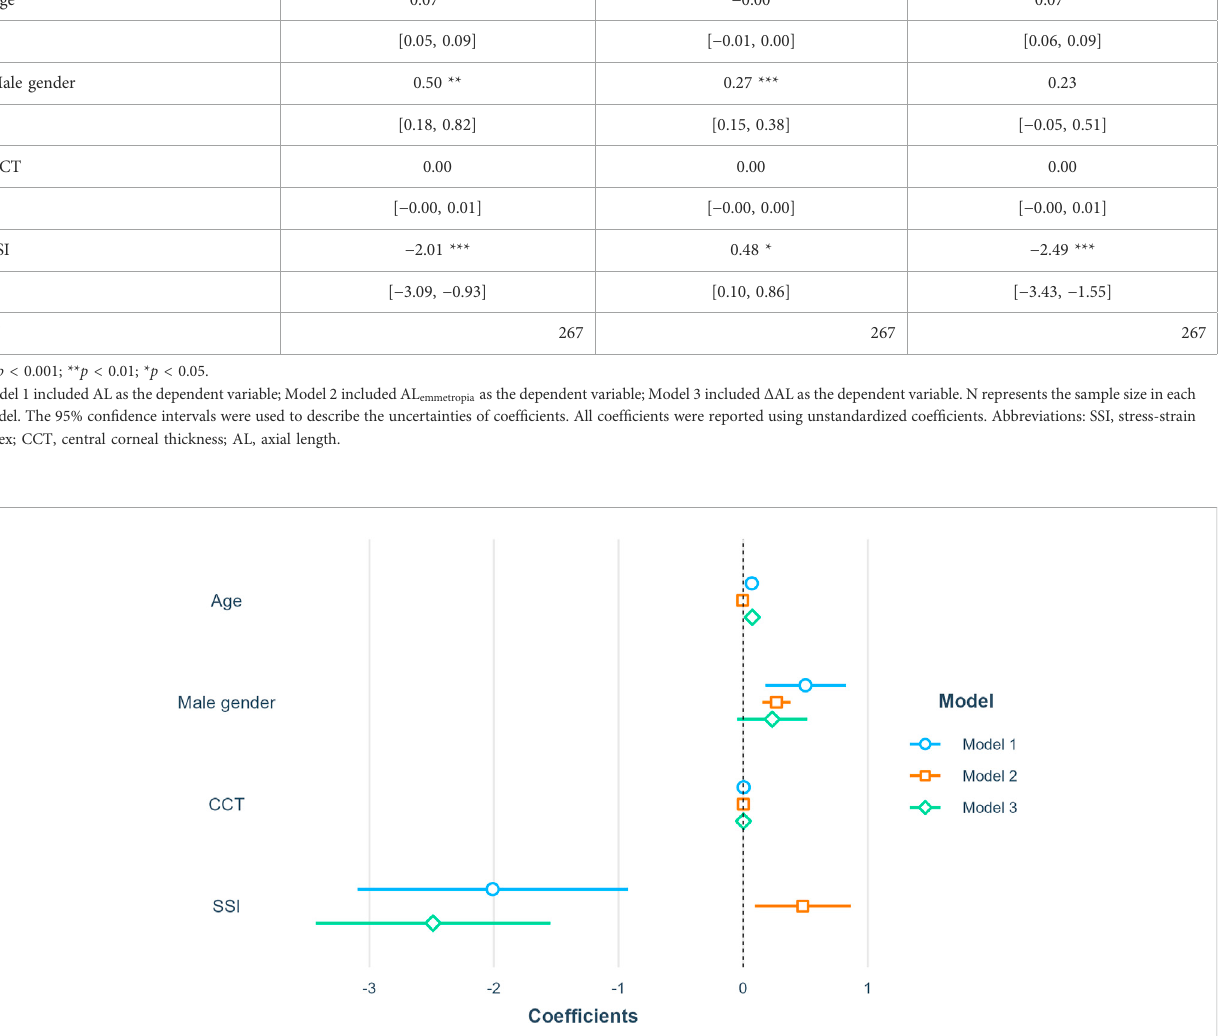
FIGURE 6 Summary of linear regression models. Model 1 included AL as the dependent variable; Model 2 included AL emmetropia as the dependent variable; Model3included Δ ALasthedependentvariable.Allcoef fi cientswerereportedusingunstandardizedcoef fi cients,and the95%con fi